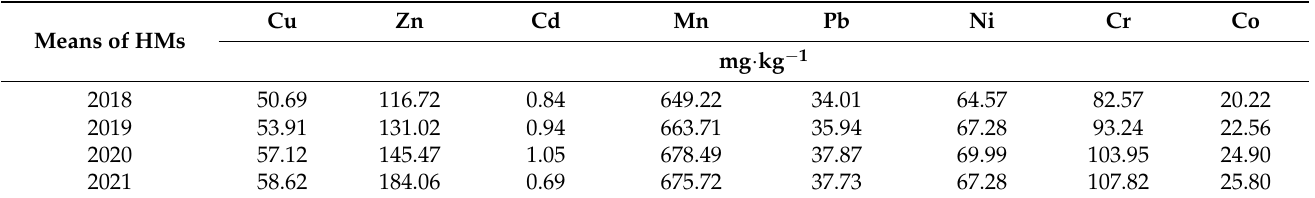
Table 4. Means values of total concentrations of HMs from